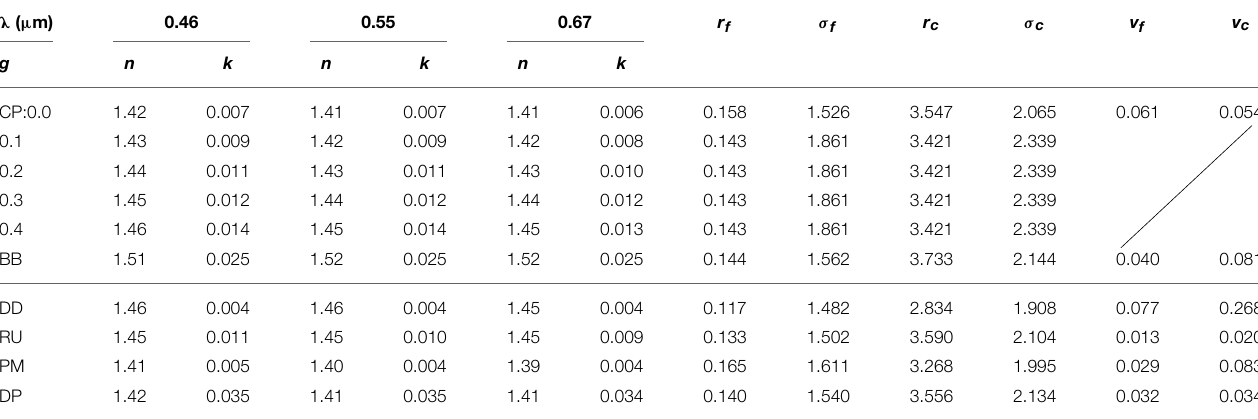
TABLE 1 | The complex refractive indices m λ = n λ − k λ i at a wavelength λ , and size distribution parameters for six aerosol types compiled by AERONET measurements are shown in the left side, and right side, respectively. λ ( µ